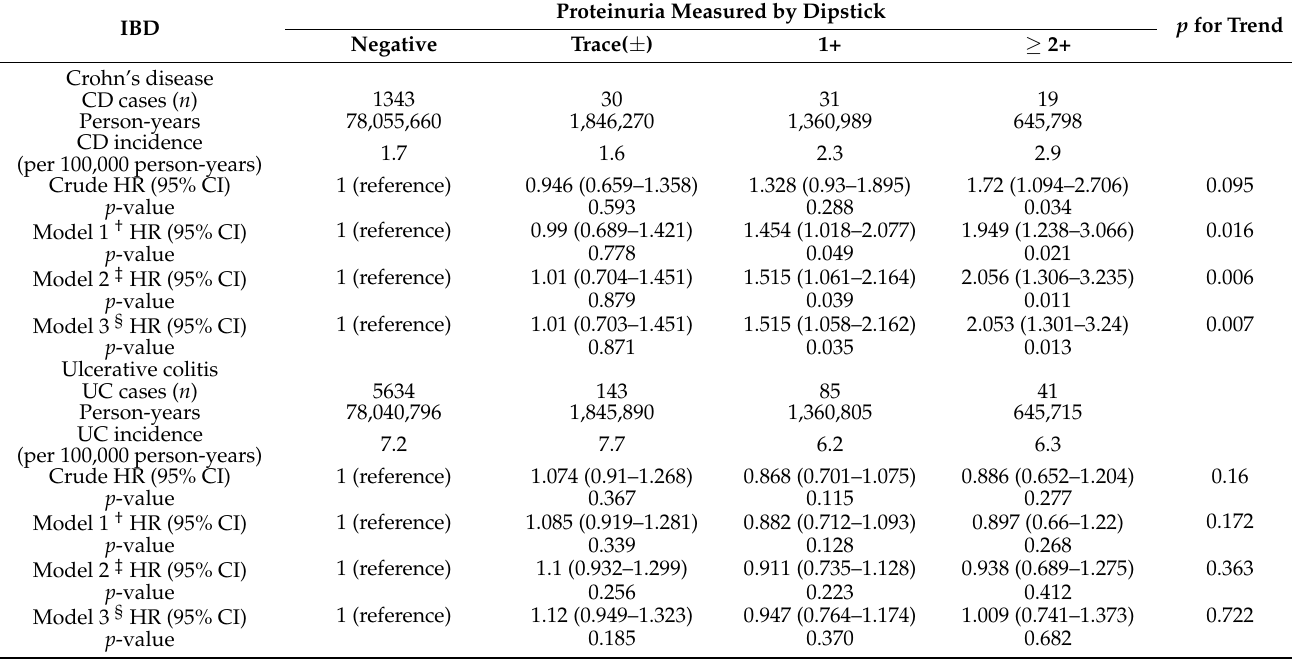
Table 2. Incidence and risk of Crohn’s disease and ulcerative colitis according to the degree of proteinuria measured by dipstick.